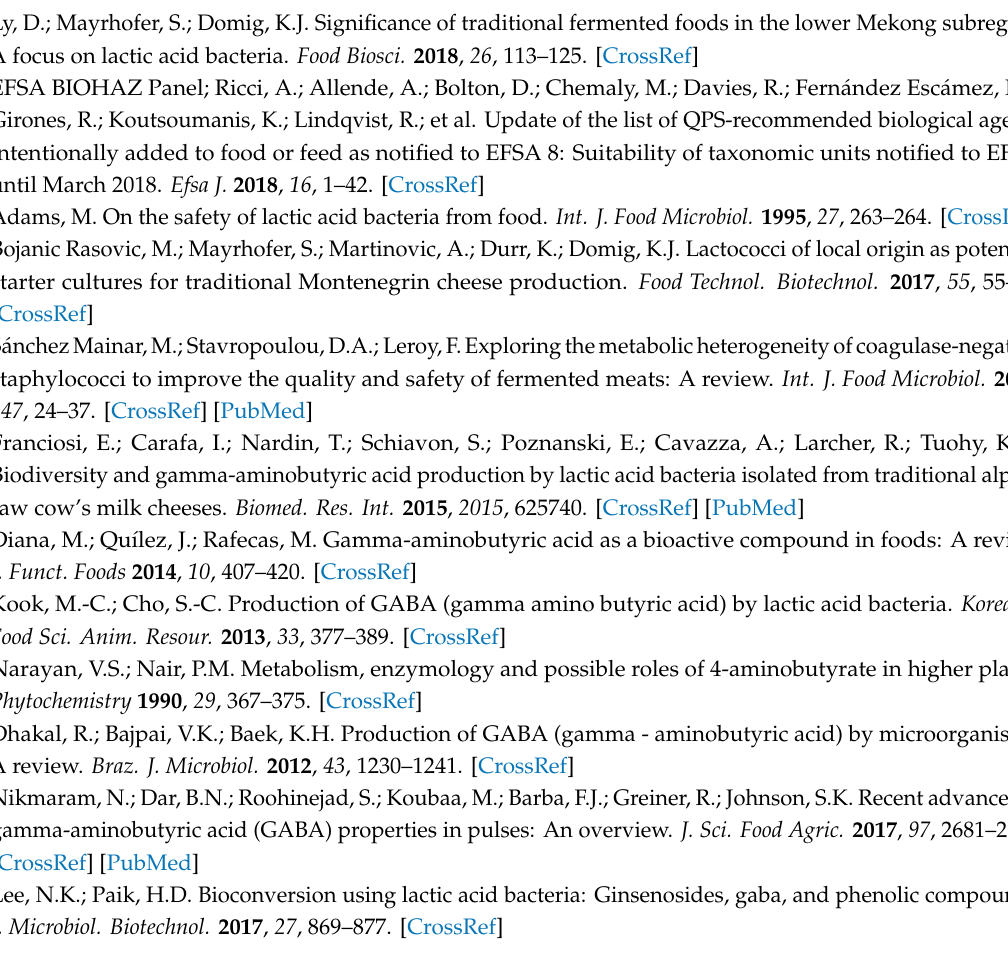
Figure S1: Thin-layer chromatography (TLC) analysis of GABA producing-LAB, Table S1: List of LAB isolates identified by partial 16S rDNA sequencing (% similarity, accession number) and MALDI-TOF MS (Bruker Biotyper) log(score) and their